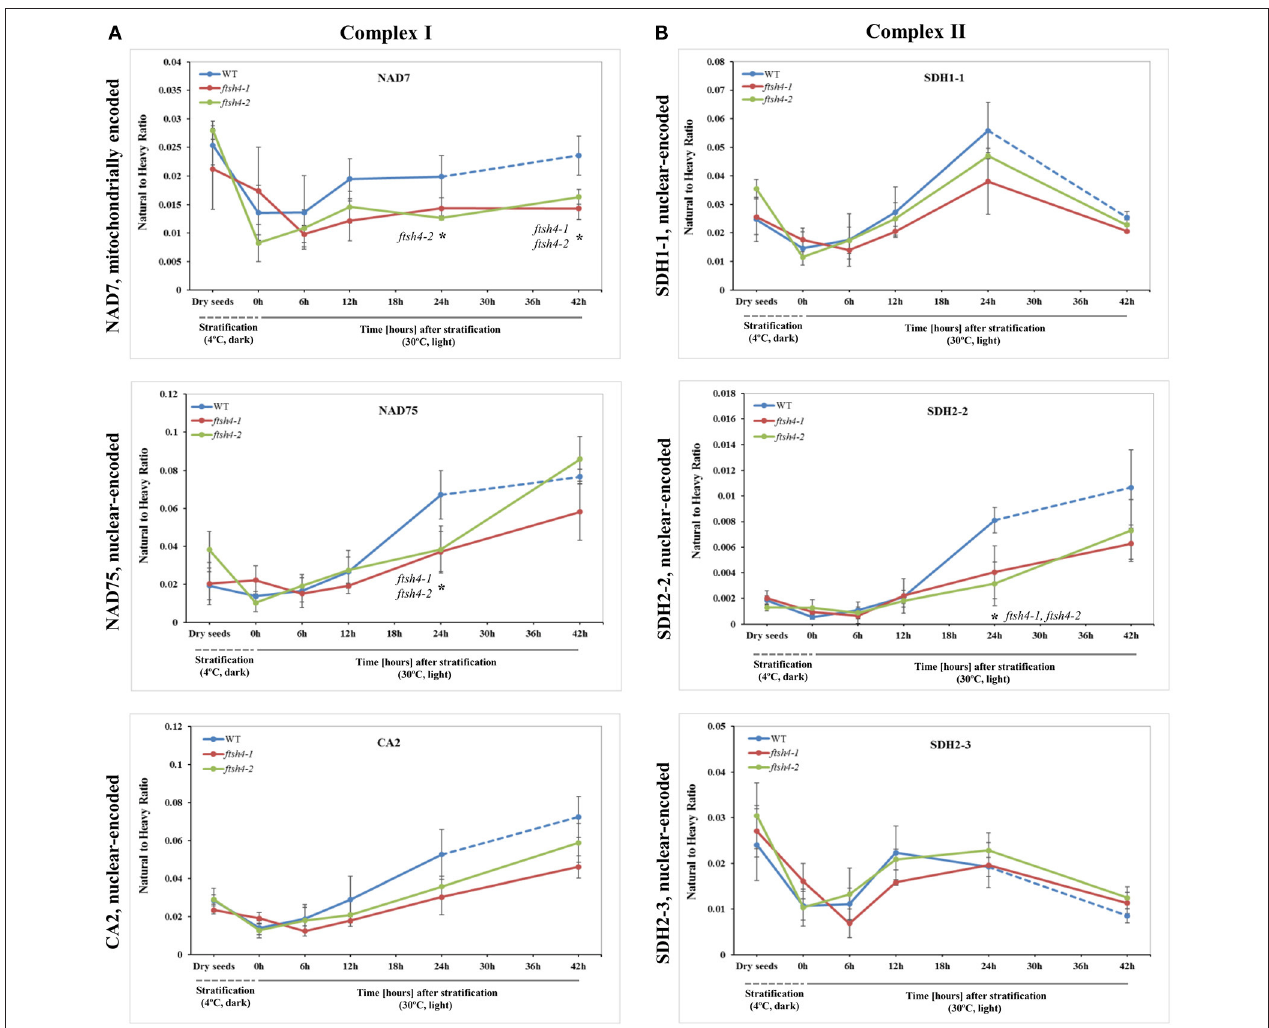
FIGURE 4 | Quantitative time-course profiling of selected complex I (A) and complex II (B) subunits in ftsh4 mutant seeds in comparison to those of WT during germination estimated by MRM. (A) Data show the abundance of NAD7 (AtMg00510) determined as the geometric mean of the peptides LVDIGTVTAQQAK, DIDSFTQQFASR and LLEFYER; NAD75 (At5g37510) and the peptides FASEVAGVQDLGILGR and NPAIIVGAGLFNR as well as CA2 (At1g47260) and the peptides NYINLAQIHASENSK, SFEQIEVER, and AIYTVGNWIR. (B) Data show the abundance of SDH1-1 (At5g66760) determined as the geometric mean of the peptides AFGGQSLDFGK, SSQTILATGGYGR and NSNGSLPTSTIR; SDH2-2 (At5g40650) and the peptide WNPDNPGKPELQDYK as well as SDH2-3 (At5g65165) and the peptides HLLSDPLVR, LQAITESETK and GLNPASAILK. The dashed line in the graph indicates the end of germination sensu stricto and the beginning of the next developmental phase. In all experiments, seeds were stratified and then incubated under LD conditions at 30 ◦ C. Stratification consisted of pre-treatment of seeds for 48h at 4 ◦ C in the dark. Dry seeds, approximately 3-months-old dry seeds; 0h, seeds after 48h of stratification and no germination; 6, 12, 24, 42h, seeds after